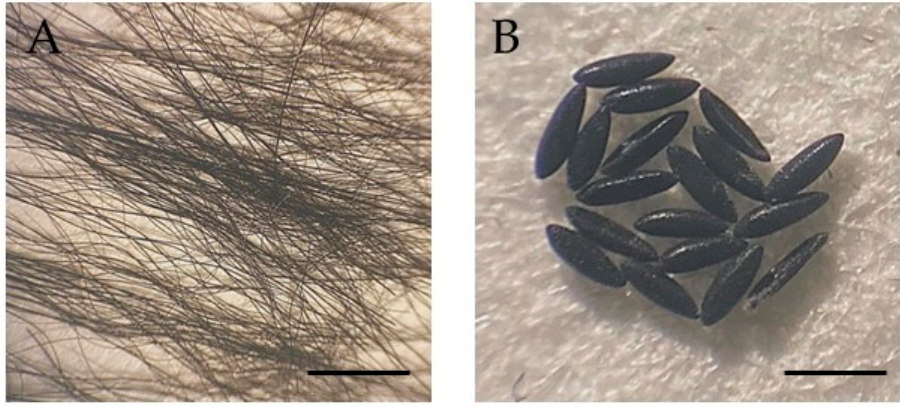
Figure 4 . Images of ( A ) black cat hairs and ( B ) mosquito eggs. Bars: 600 μ m ( A ), 500 μ m ( B ). Figure 4. Images of ( A ) black cat hairs and ( B ) mosquito eggs. Bars: 600 µ m ( A ), 500 µ m ( B ). Fluorescence spectra recorded from the solution prepared from the black cat hairs show three well-defined emission bands peaking at about 340 nm, and two bands in the 600–720 nm interval, when excited in the 220–290 nm range. Much lower emission profiles, with maxima at about 420 nm, are observed under excitation at wavelengths longer than 310 nm (Figure 5A). Excitation spectra observed at both 310 nm and 340 nm or in the red region show a signal decreasing sharply from 220 nm to the minimum at about 240 nm, and a well-defined band peaking at about 270 nm. The excitation profiles observed in the 420–530 nm range show maximum peaks at about 320 nm, followed by a slow signal decrease up to 420 nm (Figure